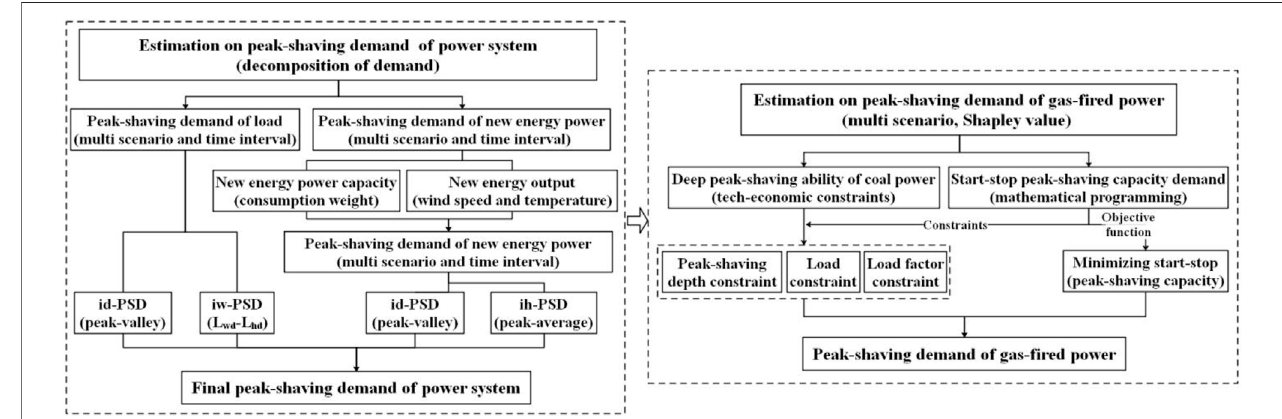
FIGURE 1 | The main frame of the research in this paper. Texts in parentheses show the research methods corresponding to the content above; “ consumption weight ” represents required proportion of renewable energy power consumption to total power consumption in each region; “ id-PSD ” , “ iw-PSD ” , “ ih-PSD ” respectively refers to intra-day peak shaving demand, intra-week peak shaving demand, intra-hour peak shaving demand; “ L wd -L hd ” means max load on weekdays minus that on holidays; More details are described